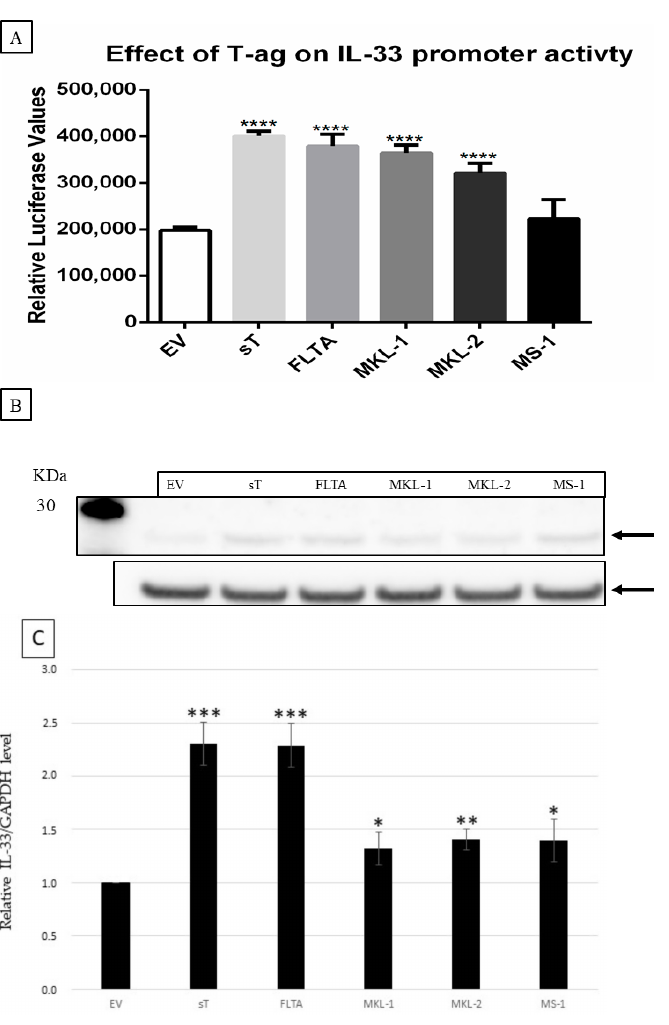
Figure 3. MCPyV T-antigens stimulate IL-33 promoter activity and induce IL-33 expression levels. ( A ) MCC-13 cells were co-transfected with a luciferase reporter vector driven by the IL-33 promoter fragment spanning the nucleotides − 1050/+50, together with an expression plasmid for full-length LT (FLTA), tLT (LT MKL-1 , LT MKL-2 , LT MS-1 ), sT, or pcDNA3 (empty vector; EV). Luciferase activity was assessed 24 h after transfection. Each bar represents the average of three independent parallels ± SD. Luciferase values were normalized for total protein in each sample. ** p ≤ 0.01, *** p ≤ 0.001 and **** p ≤ 0.0001. ( B ) MCC-13 cells were transfected with expression plasmids for LT or tLT, sT, or empty vector, and protein expression was measured at 24 h after transfection. IL-33 expression was normalized with GAPDH. The image is representative for three independent experiments. ( C ) Ratio of the values obtained by densitometric scanning of the signals obtained with IL-33 and GAPDH antibodies. The ratio for empty vector:GAPDH was arbitrarily set as 1.0 ± standard deviation (* p < 0.05; ** p < 0.01; *** p < 0.001; **** p <0,0001).